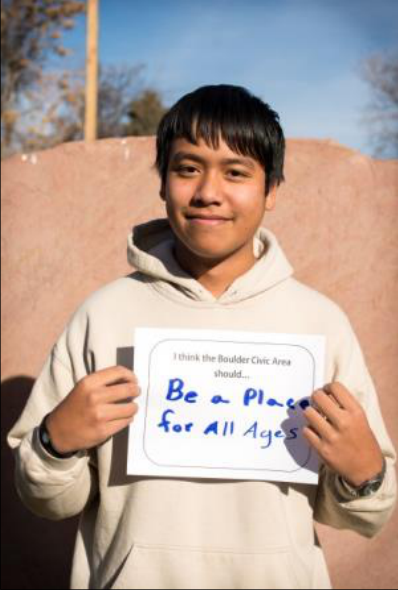
Figure 14. An AVID student with his vision for the Boulder Civic Area to “be a place for all ages” (photo courtesy Stephen